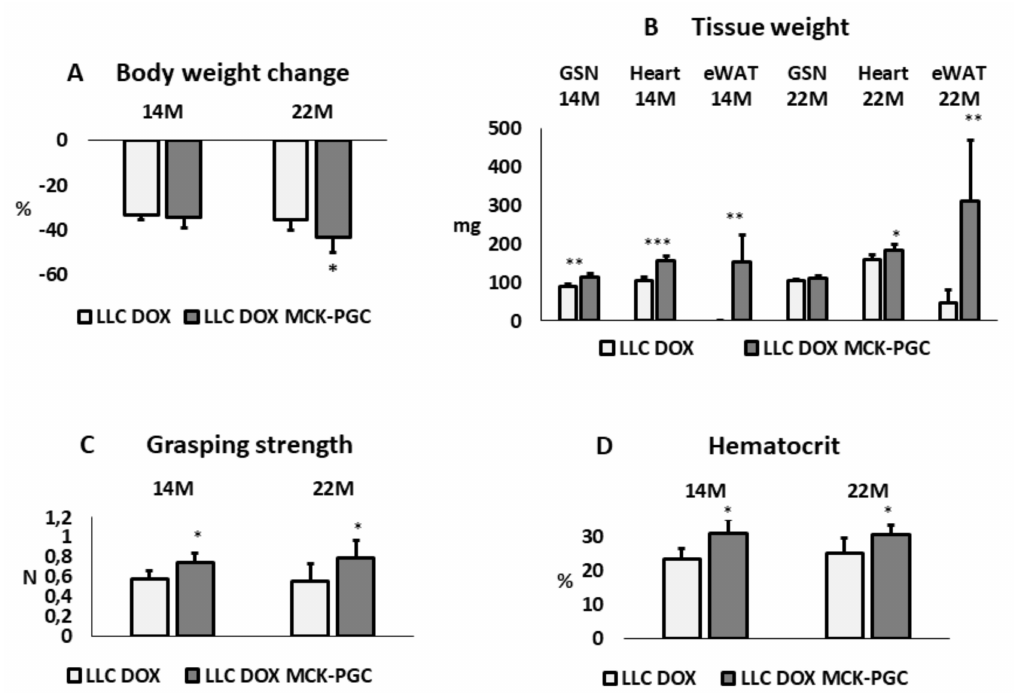
Figure A1. ( A ) Body weight change during tumor growth and chemotherapy experimental period of 14- and 22-month-old WT ( n = 5; 7) and MCK-PGC-1 α mice ( n = 5; 5) bearing the LLC tumor. Data are reported as % ± SD of the initial body weight (IBW); ( B ) Gastrocnemius (GSN), heart, and epididymal white adipose tissue (eWAT) weight; data are expressed in mg ± SD; ( C ) Voluntary grasping strength; data (means ± SD) expressed in Newton. ( D ) Hematocrit. Data (means ± SD) expressed as percentages of total blood. For all panels, the significance of the differences was assessed by Student’s t-test for independent samples: * p < 0.05, ** p < 0.01, *** p < 0.001 vs. LLC DOX